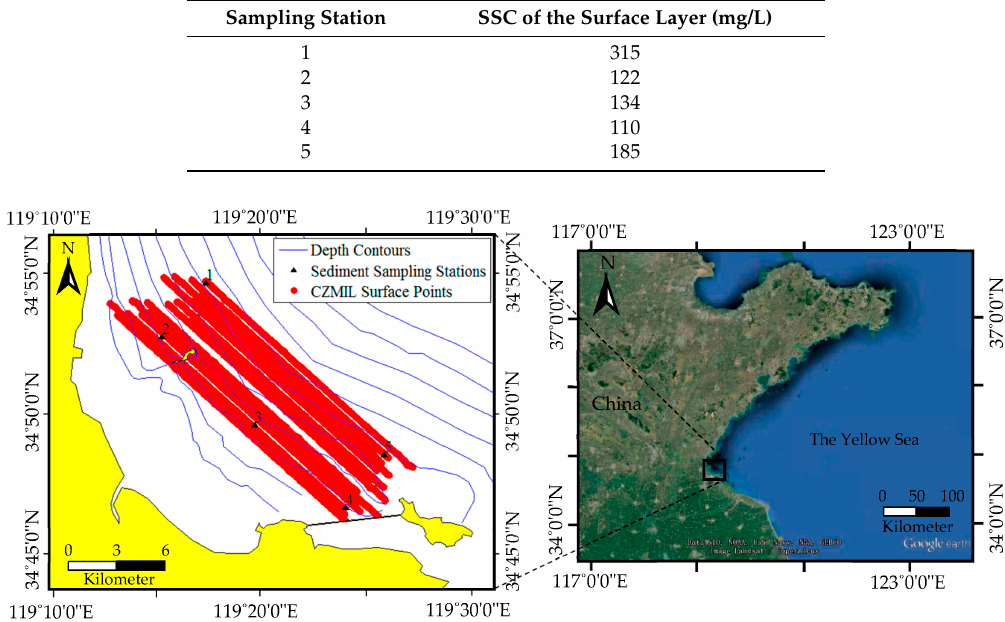
Table 2. Suspended sediment concentration (SSC) of the surface layer in each sampling station.